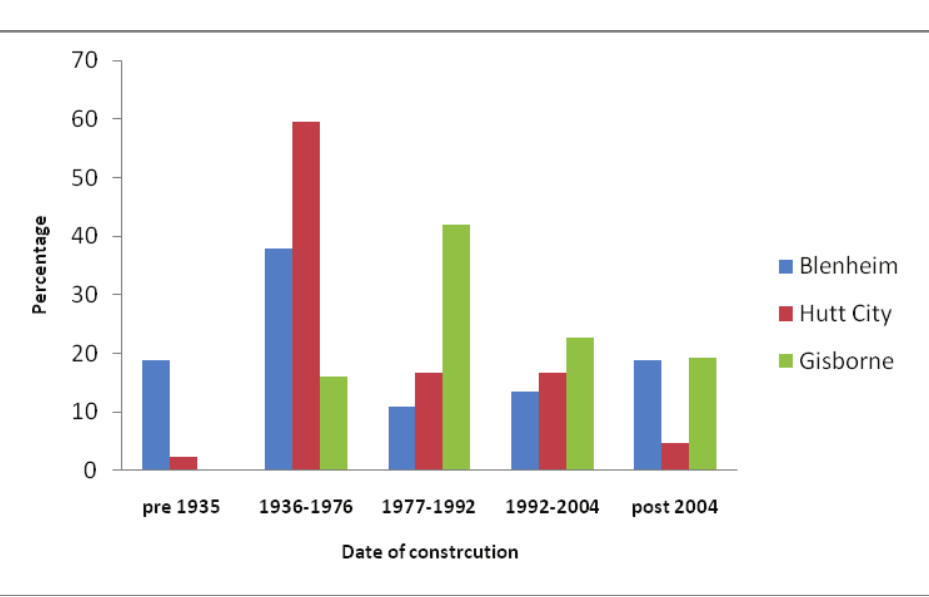
figure 1. date of construction in three cities’ wastewater pumping